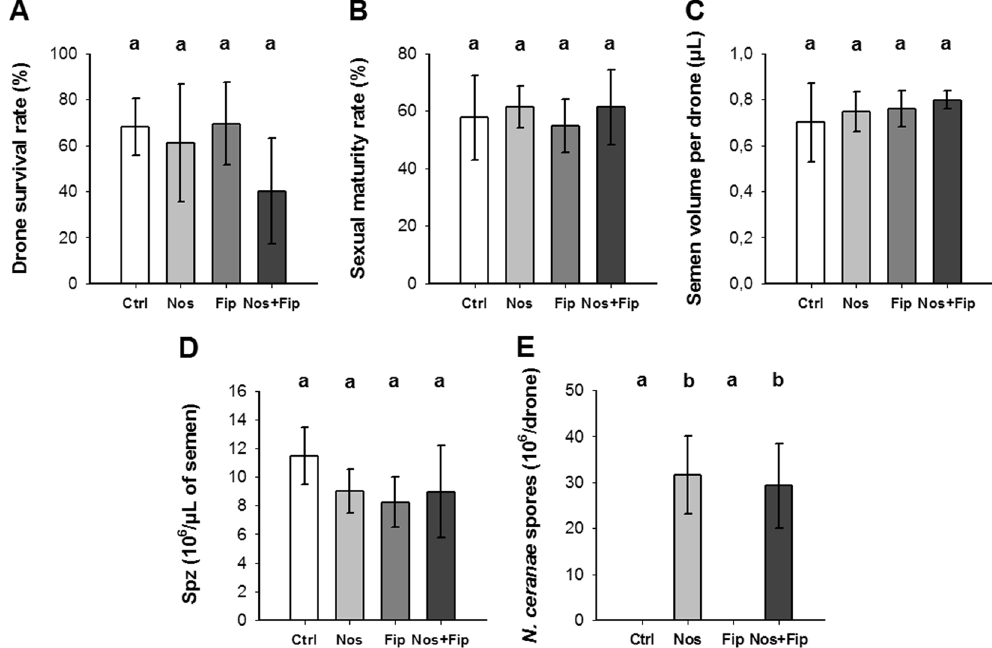
Figure 2. Effects of the stressors, alone or combined, on drone life traits. The effects of the pathogen and the insecticide alone or in combination were studied at the individual level. The survival rate ( A ), the sexual maturity rate ( B ), the semen volume per drone ( C ) and the spermatozoa concentration ( D ) were measured for each hive (n = 4 for each stressor modality). The level of N. cerana e infection ( E ) was determined using 3 samples of 5 drones per hive (n = 12 for each modality of treatment). The data represent the mean values ± standard deviations. Statistical analyses were performed using a post-hoc Wilcoxon test for the first four parameters ( A – D ). A generalized linear mixed model was applied to the level of N. cerana e infection ( E ) considering a random effect of the hives from which the drones came. Bars with different letters indicate a significant difference at (or below) the 0.05 level between